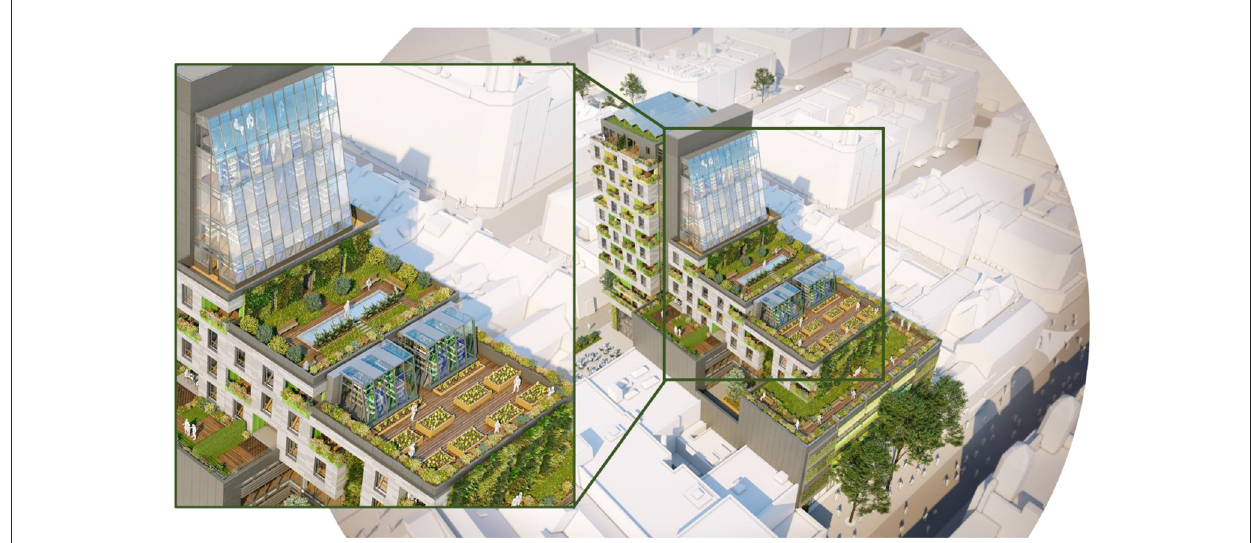
FIGURE4 Aerial image of the proposed development highlighting space for community led urban farm. Visible also are green balconies and green walls. Image used in focus group presentations and reproduced with kind permission from the